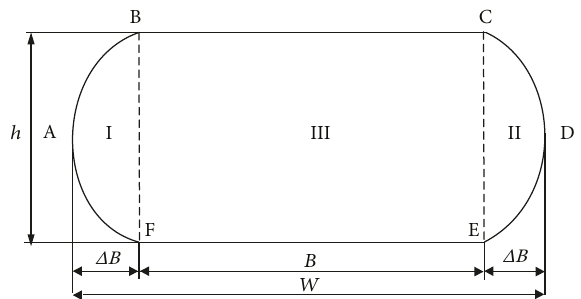
Figure 12: The sectional model of the extruded wire.